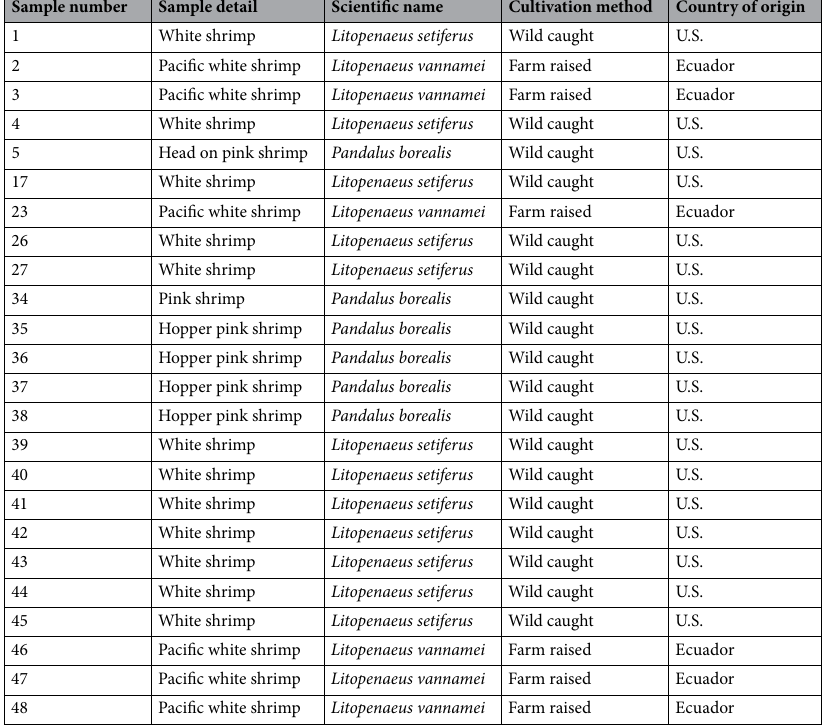
Table 2. Shrimp sample details for microbiome study collected from supermarkets located in Florida and